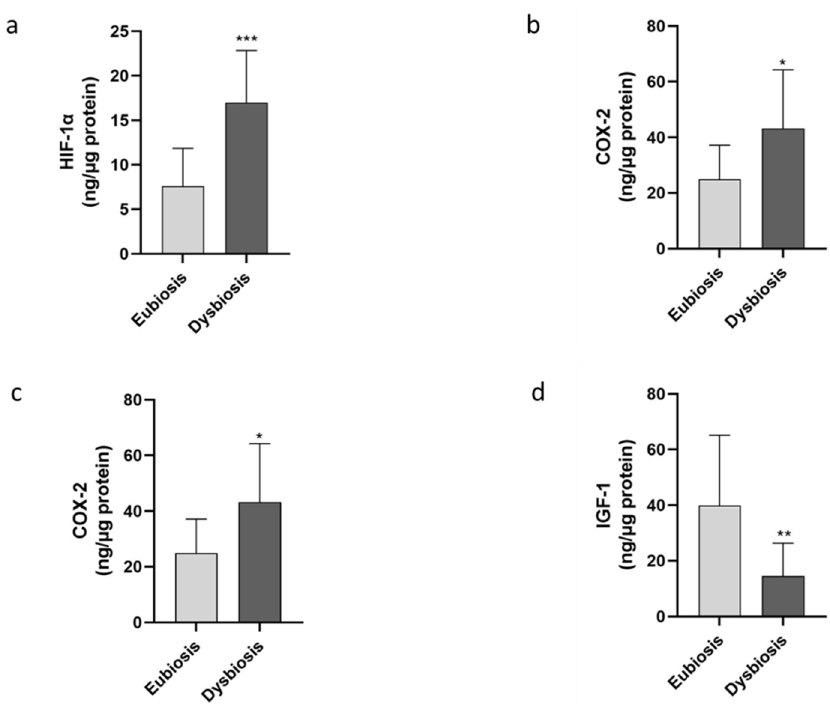
Figure 4. Evaluation of inflammatory and anti-inflammatory molecules. The inflammatory markers were quantified in the two different groups by specific immunoenzymatic assay. In particular, the levels of HIF-1 α ( a ), COX-2 ( b ), IL-10 ( c ) and IGF-1 ( d ) were analyzed. The data are the mean ± SEM of three different experiments, each performed in duplicate. Statistical analysis was performed by unpaired t-test: * p < 0.05, ** p < 0.01, *** p < 0.001 vs. eubiosis group.